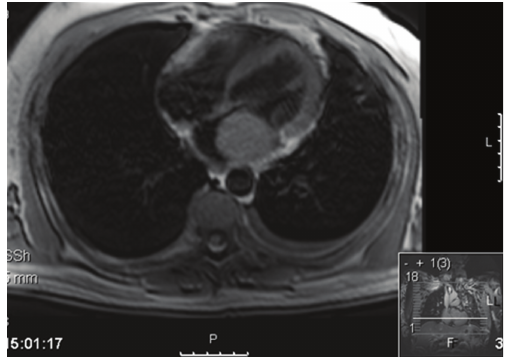
Figure 4: Cardiac magnetic resonance scan (MRI) showing left atrial mass obstructing left ventricular outlet